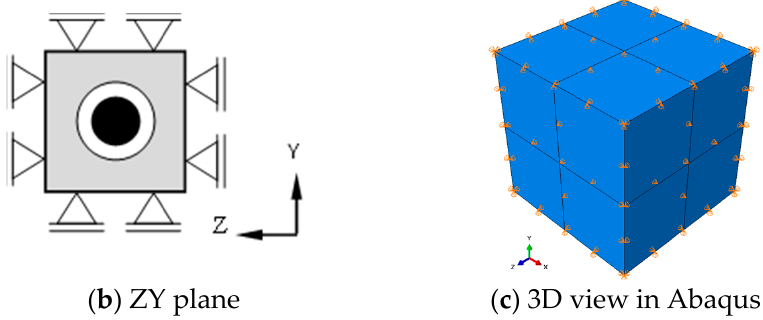
Figure 6. Boundary conditions of the 3D FE-Model ( a , b ): illustrative presentation, ( c ) Model in Abaqus.